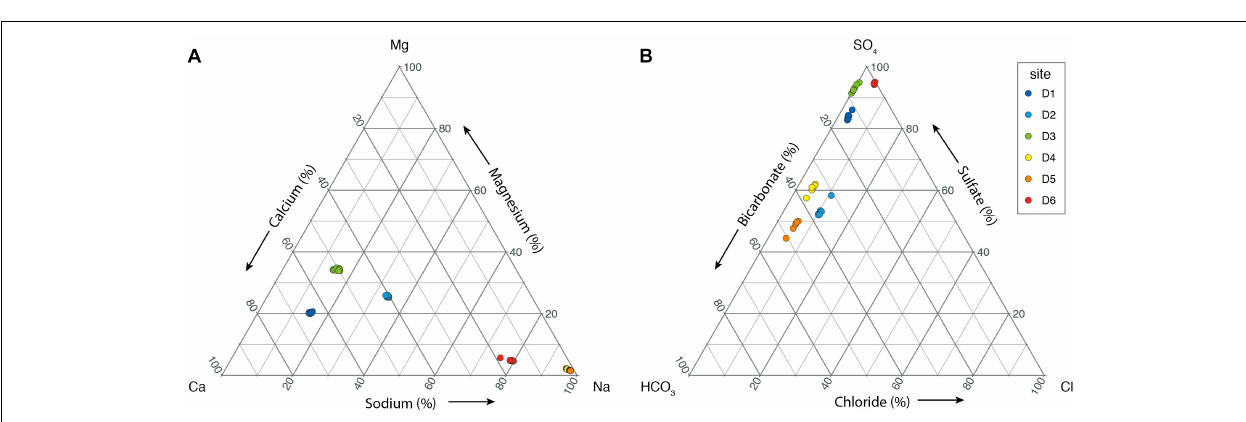
FIGURE 4 | Ternary diagrams illustrating the distribution of major cations (A) and anions (B) from each DeMMO